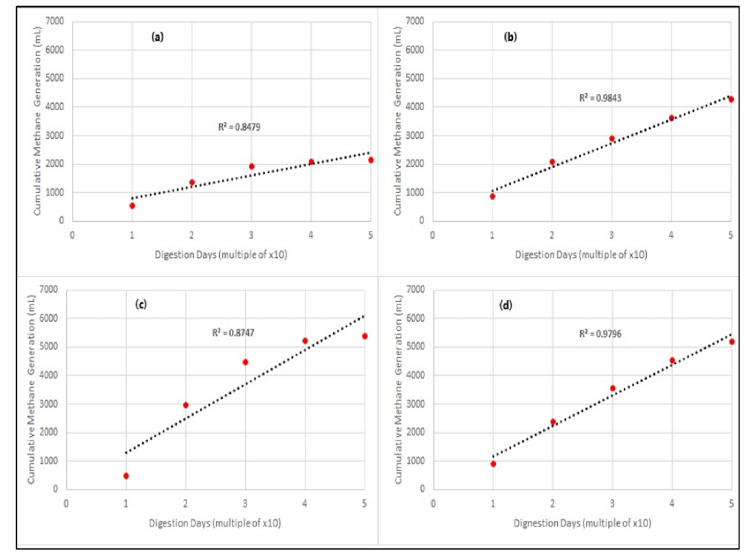
Figure 5. Simple linear regression plots; ( a ) R c , ( b ) R ct , ( c ) R u , and ( d ) R i